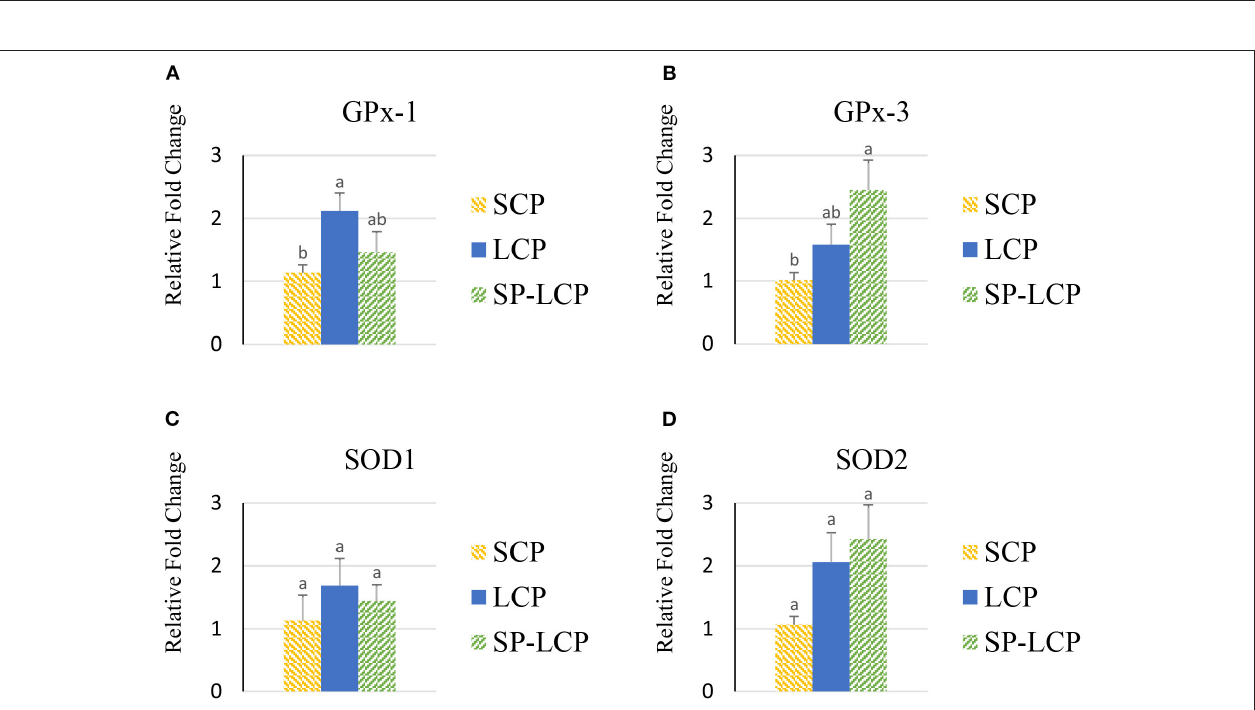
FIGURE 6 | Effects of Spirulina on the expression of circulating antioxidant defense system. Relative mRNA abundance of glutathione peroxidase 1 (GPx-1) (A) , glutathione peroxidase 3 (GPx-3) (B) , superoxide dismutase 1 (SOD1) (C) , and superoxide dismutase 2 (SOD2) (D) in the blood of broilers on day (d) 37 were determined by real-time qPCR. Treatments include standard corn/soy (SCP) diet as control and low crude protein without (LCP) or with Spirulina (SP-LCP). Data are presented as mean ± SEM ( n = 8/group). Means with different letters are significantly different ( P < 0.05).